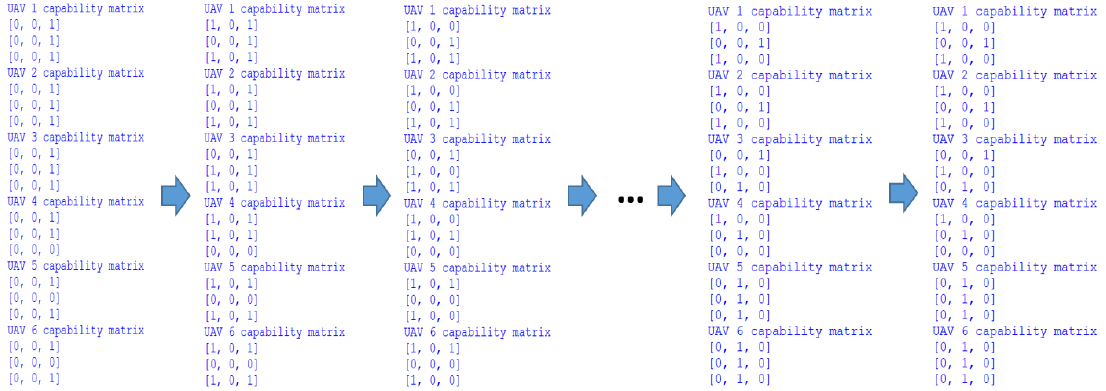
Figure 18. Capability matrixes changes during the negotiation process. Sensors 2018 , 18 , x FOR PEER REVIEW